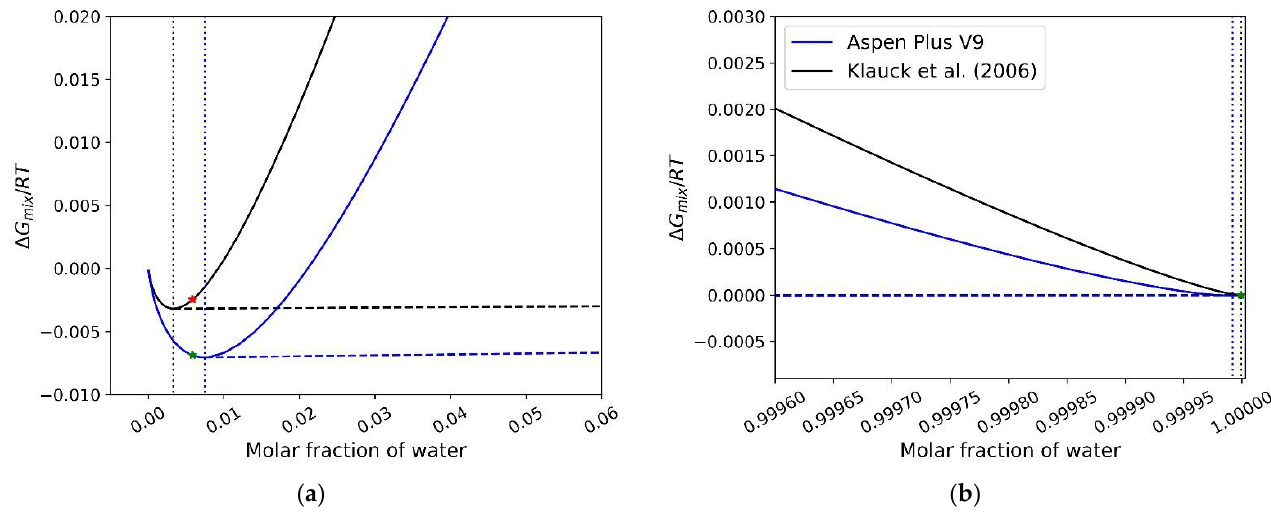
Figure 7. Closer View of ∆ G mix /RT and Mutual Solubility Regions of Water/n-Octane system. The NRTL model implemented with win Aspen Plus V9 and Klauck et al (2000) binary interaction parameters (BIP) at 70 °C. ( a ) highly diluted water in n-octane region, ( b ) highly diluted octane in water region. Note: reported data points are from [23,24].